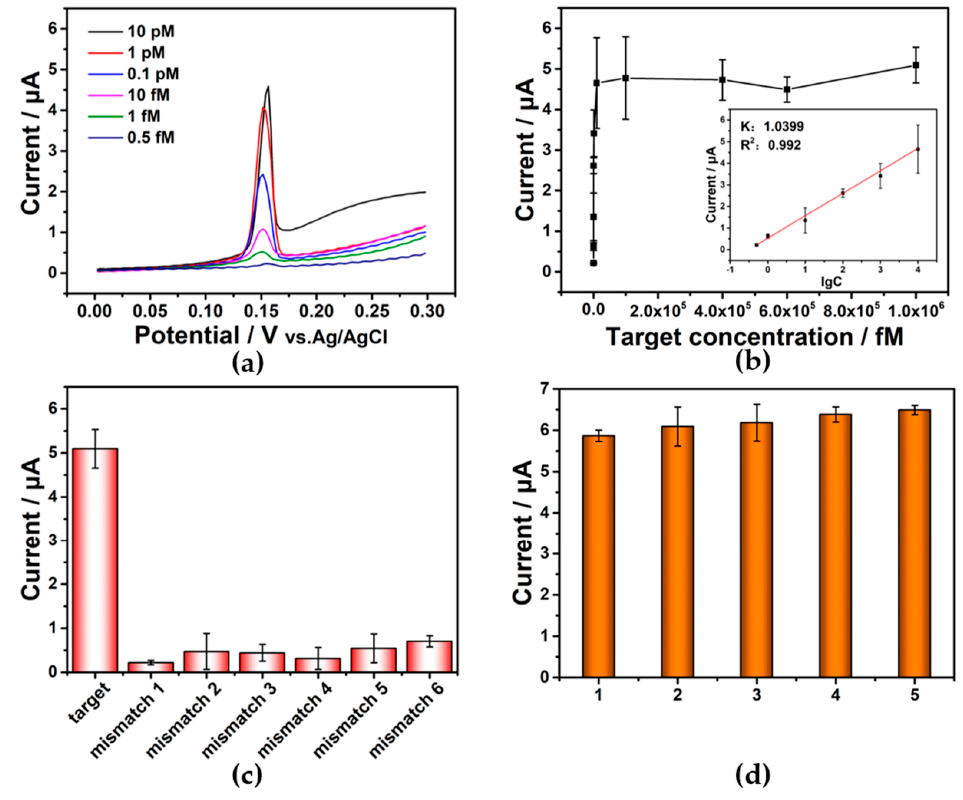
Figure 4. ( a ) Voltammetric responses at different ctDNA concentrations. ( b ) Plot of peak current obtained from different concentrations of ctDNA (target). Inset: linear plot from the peak current and logarithm of ctDNA concent rations. The error bars are from the results of multiple independent experiments. ( c ) CV responses to the target (1 nM) and six mismatched sequences (1 nM), respectively. ( d ) Repeatability of electrochemical sensors. (1, 2, 3, 4, 5 represent five electrochemical sensors constructed under the same conditions. Target: 1 nM).